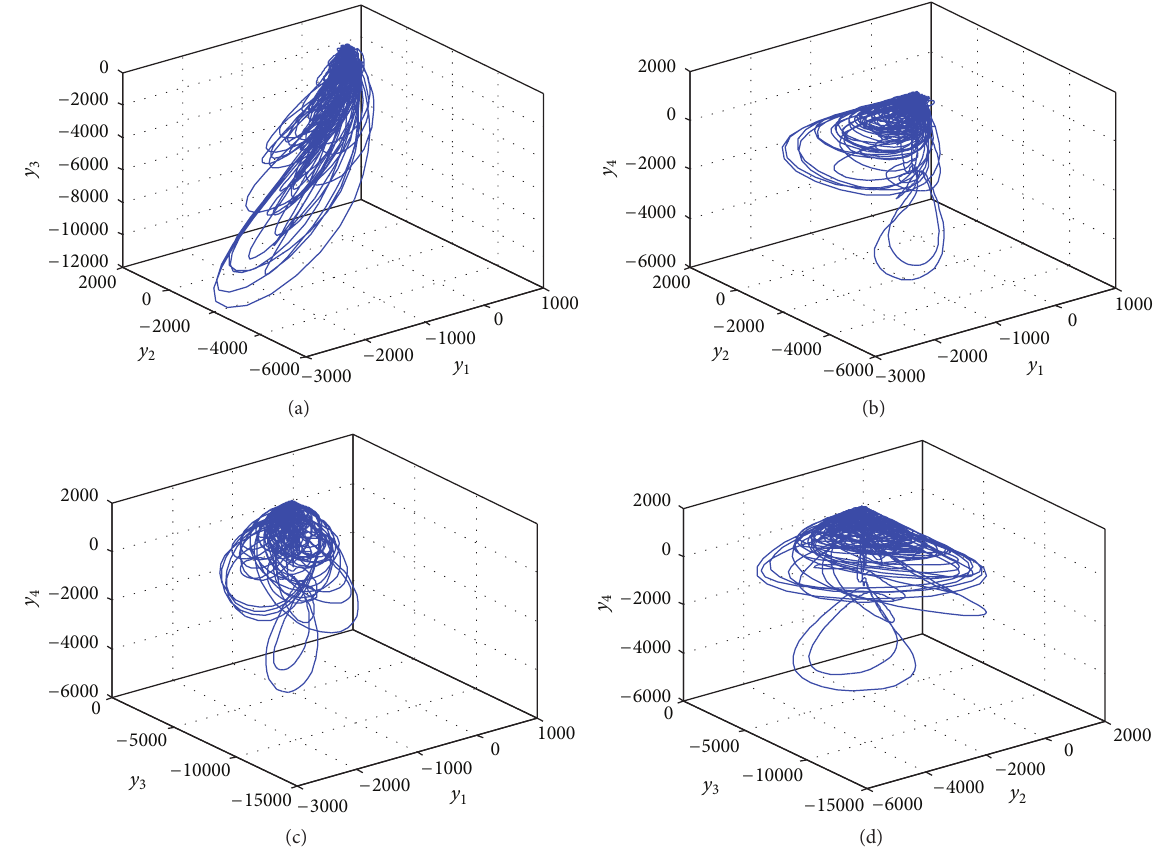
Figure 5: Projections of the phase portrait for chaotic system (3) of Case